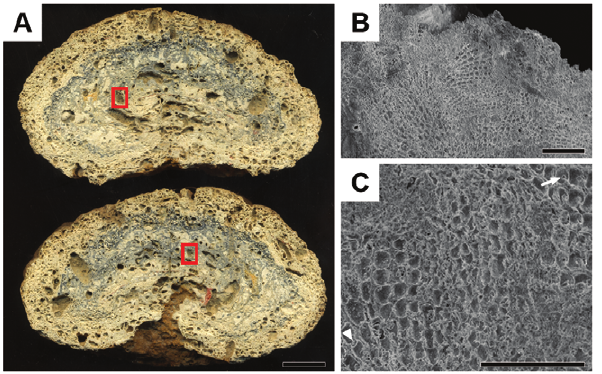
Figure 3. Stereomicroscopy and scanning eletron microscopy images of a isotopic dated rhodolith. (A) A section of the rhodolith made along its longest axis. The red squares indicate the regions where fragments were removed for isotopic analysis. (bar=2 cm); (B and C) Scanning electron microscopy images showing the typical cellular organization of CCA species circumscribing the region where the fragments were collected for isotopic dating. Note in image ‘‘C’’ the presence of ‘‘secondary pit-connections’’ (arrow) and of cell fusions (arrow head) among mineralized cell walls (Bars: B=150 um and C=80